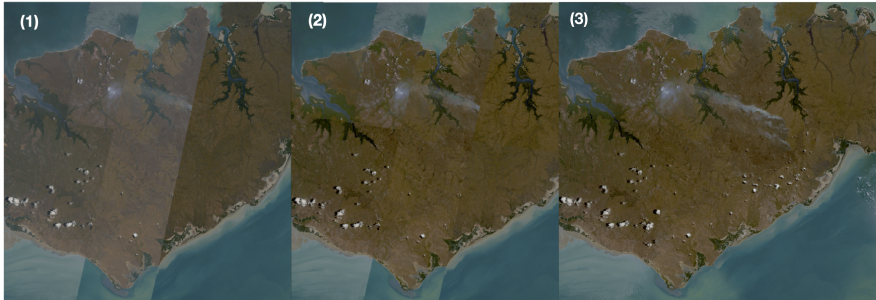
Figure 14. Illustrations of the ASTER mosaic quality over Van Diemen Gulf (Australia): (1) patch of the natural color ASTER granules; (2) patch the IDT colorized granules; (3) seamless blending of IDT colorized